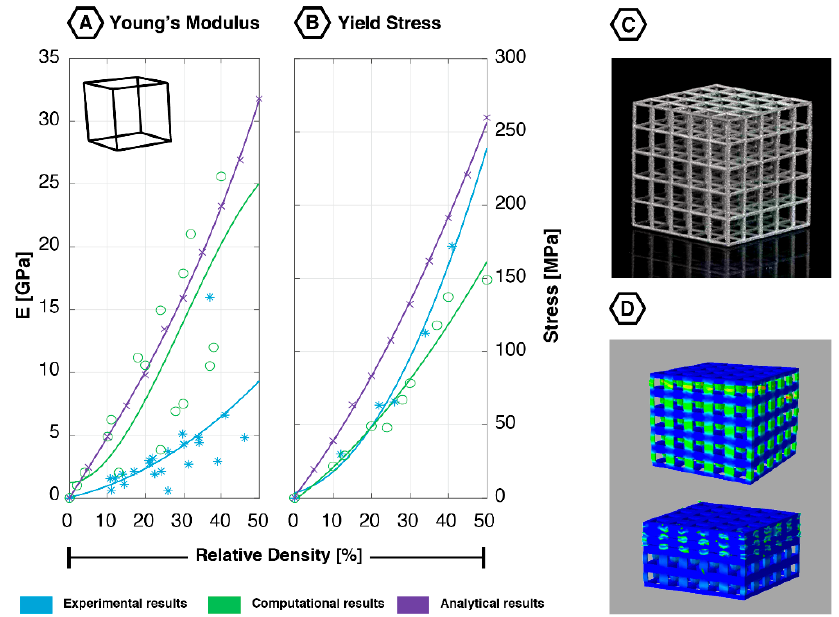
Figure 2 . Mechanical properties of the cubic unit cell based on experimental, computational, and analytical data: ( A ) Young’s modulus [18,19,21,40–42,44,45,47–50] ; ( B ) yield stress [18,21,40,47,48] ; ( C ) additively manufactured cubic lattice (5 × 5 × 5 unit cells); ( D ) start and end stage of the deformation procedure showing a layer-by-layer collapse; reprinted with permission from Ref. [40] © 2015 Elsevier.